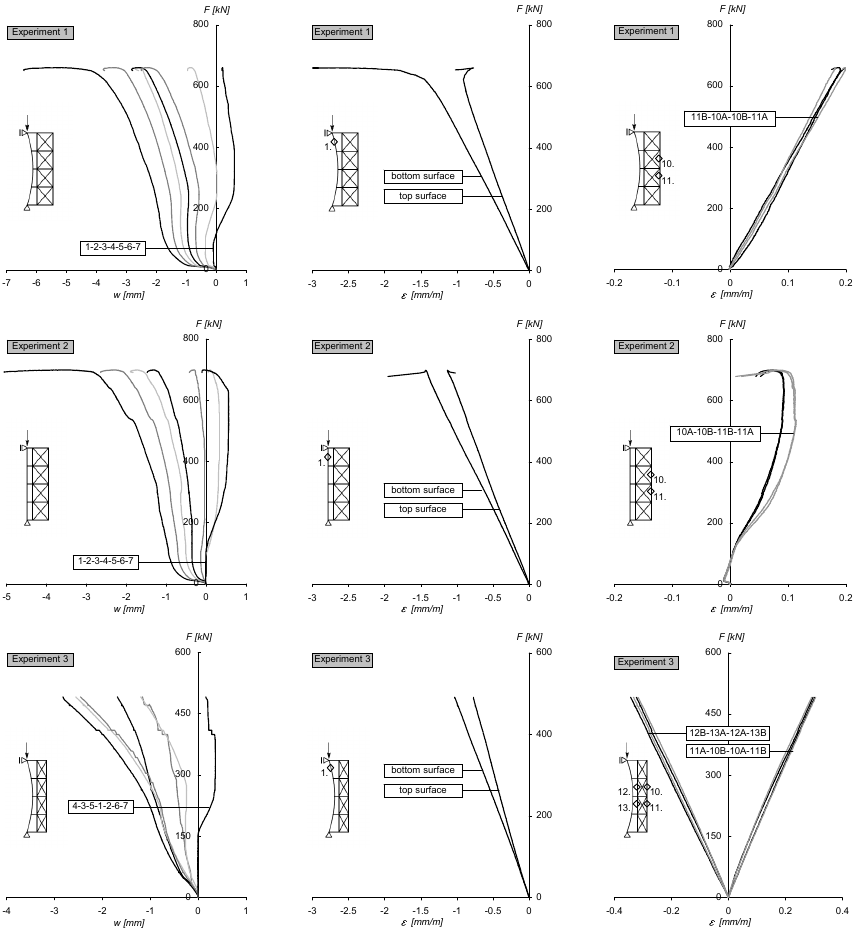
Figure 9: Load-deformation graphs of the steel column at 7 locations; load-strain graphs of the steel column at location of maximum bending; load-strain graphs of the glass panes at location of maximum bending (i.e., edges). Measurement locations are indicated by diamond markers and numbers corresponding to Figure